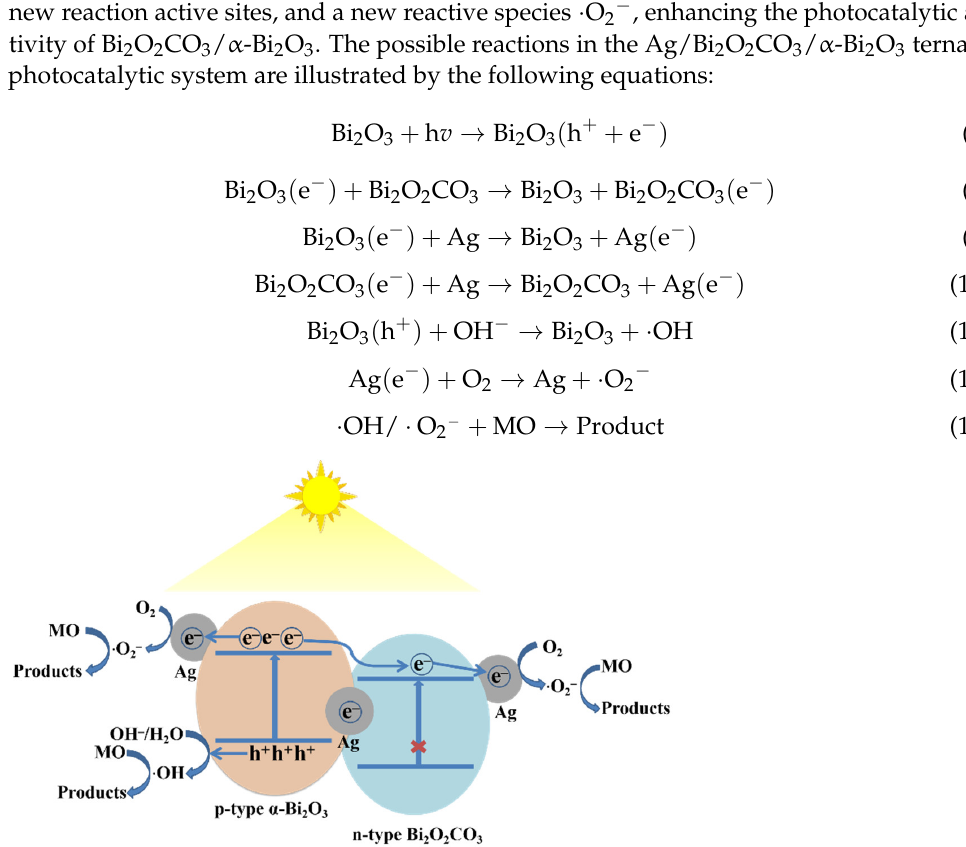
shown in the image, no significant loss is found after four successive cycles; 89.8% of MO was degraded in the fifth run after 60 min of visible light irradiation, suggesting that the sample is stale and not photo-corroded in the photocatalytic